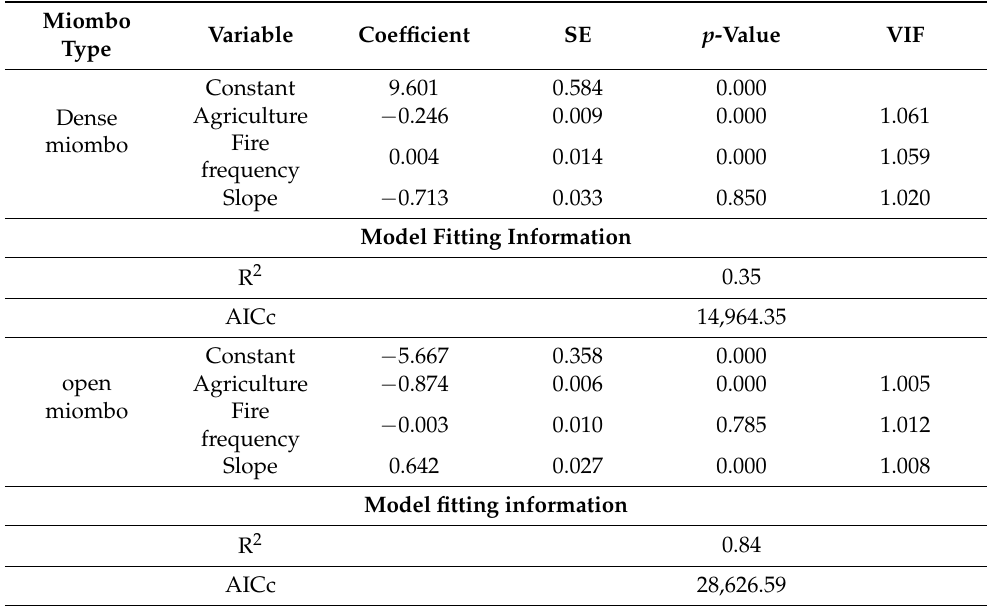
Table 1. OLS results for the two types of miombo